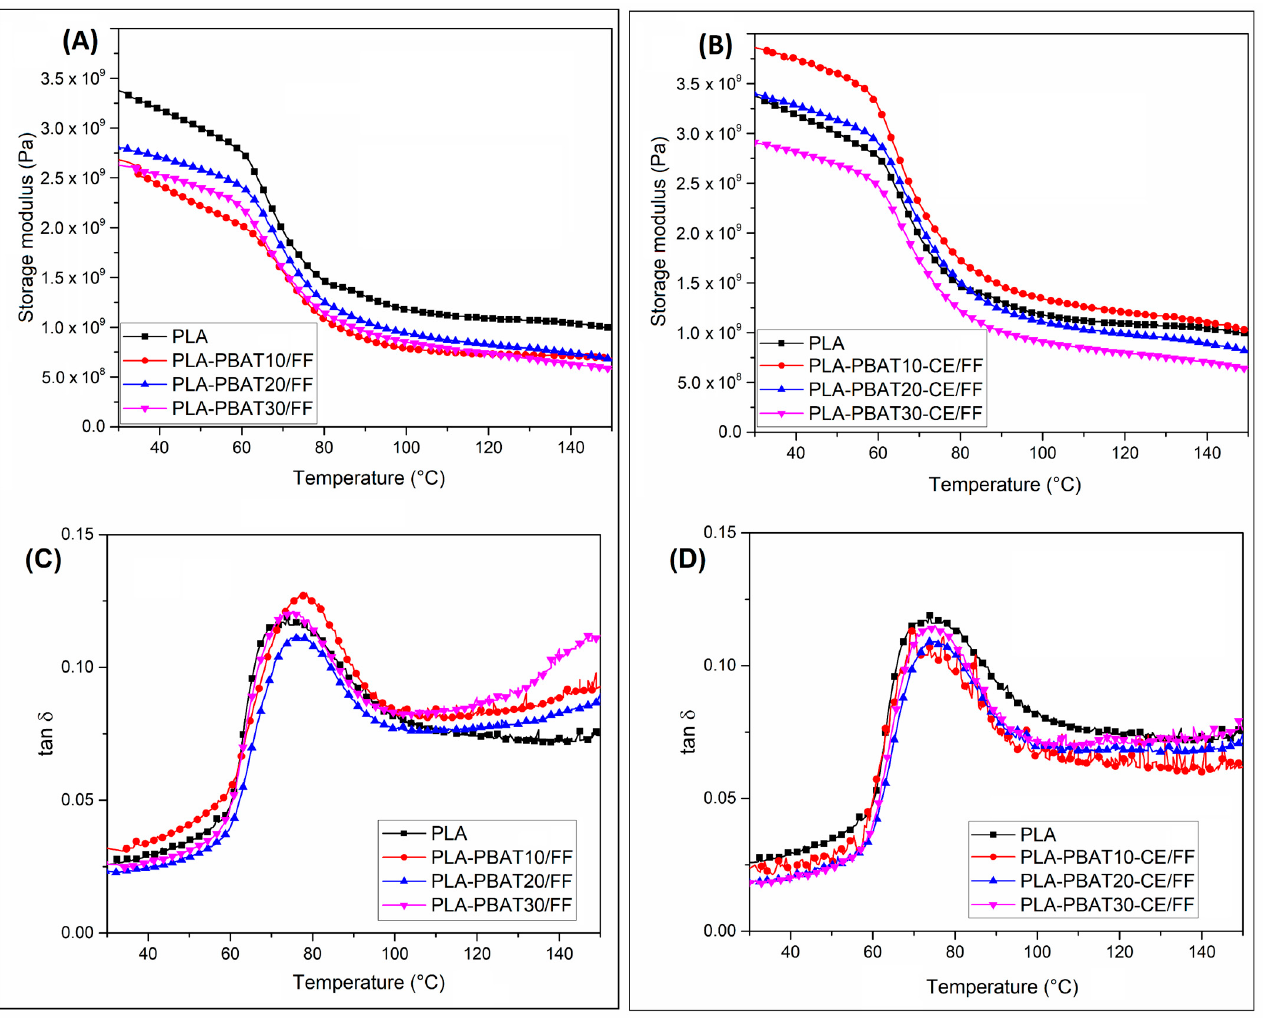
Figure 4. DMTA analysis results for compression molded FF composites. Storage modulus and tan δ curves for ( A , C ) PLA- PBAT matrix type composites, and ( B , D ) PLA-PBAT-CE matrix composites.